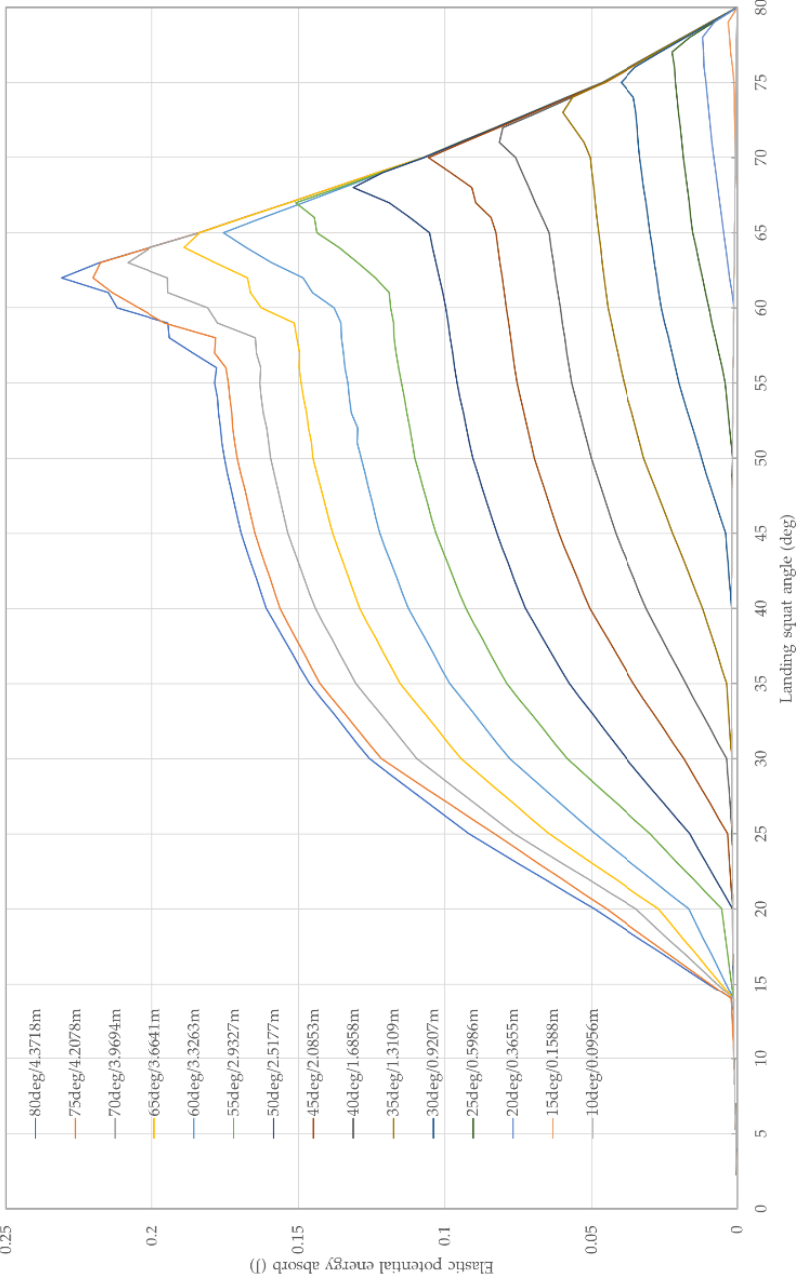
Figure 8. The elastic potential energy absorbed at different landing squat angles from different dropping heights.